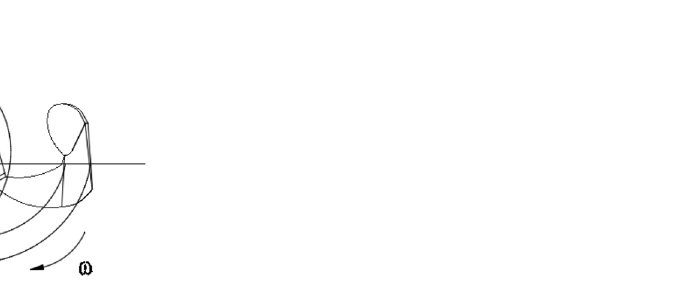
Figure 3. Blade movement trajectory. V is the speed of moving forward (mm/s), ω is the blade rotation speed (rad/s), and S1 is the volume of mud thrown (mm 3